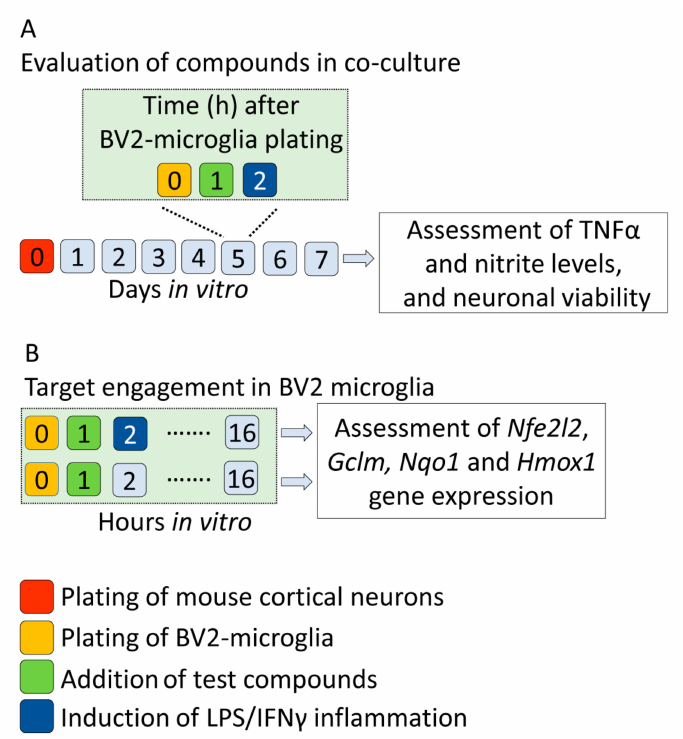
Figure 5. In vitro study design for assessment of anti-inflammatory, anti-oxidant and neuroprotective e ff ects in neuron-BV2 microglia co-culture, as well as target engagement in BV2 microglia. ( A ) Co-culture experiment. Day 0: dissection of brains and plating of mouse cortical neurons; day 5 in vitro: addition of BV2-microglia to prepare co-culture, addition of test compounds to co-cultures and induction of inflammation by lipopolysaccharide / interferon gamma (LPS / IFN γ ); day 7 in vitro: collection of culture media for tumour necrosis factor alpha (TNF α ) and nitrite (NO 2 − ) analysis, fixation of co-culture cells to culture plates for assessment of neuronal viability. ( B ) Target engagement. At 1 h after BV2-microglia plating, desmethylclomipramine or ionomycin was added to BV2 cultures. One hour later, inflammation was induced with LPS / IFN γ to one set of cells and another set of cells was left without inflammation. After 16 in vitro, target expression was assessed by quantifying the e ff ects of the treatments on the expression of Nfe2l2 and Nrf2 target genes ( Gclm , Nqo1 and Hmox1 ). Both experiments were